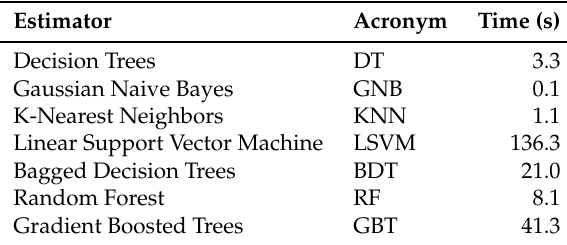
Table 1. Training times for traversability